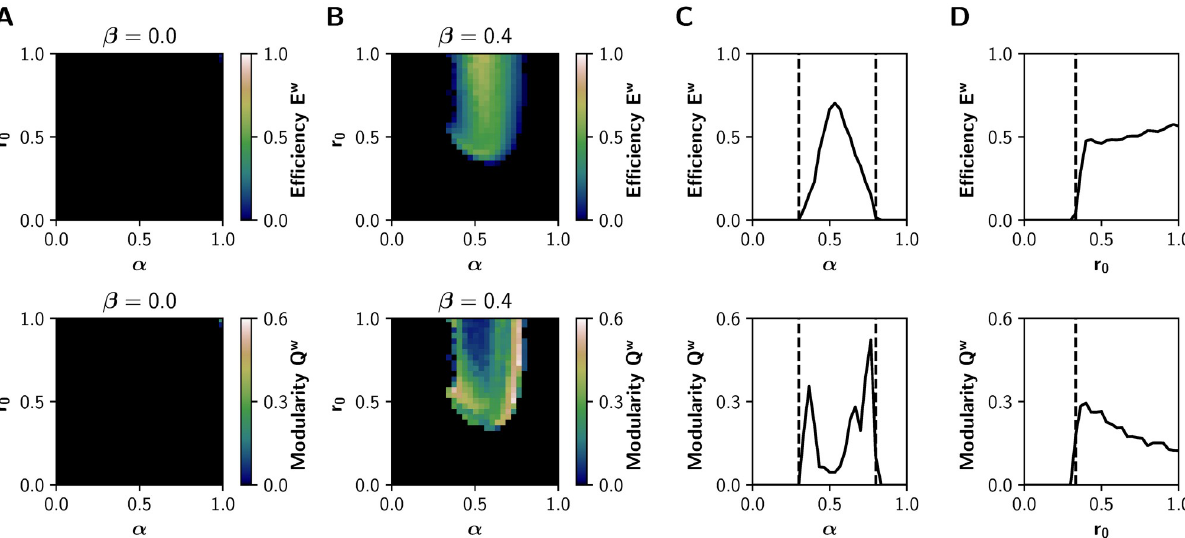
Fig 4. Network features in the ( α , r 0 ) parameter space. A-B) Global efficiency E w (integration) and modularity Q w (segregation) of the graphs derived from the sFCs of the BOLD-like signals, for A) β = 0 (no action of the inhibitory gain) and B) β = 0.4. C) Transitions through the critical boundary in the α axis, with a fixed r 0 = 1 mV − 1 and β = 0.4. Critical transition points represented by black dashed lines at α = 0.3 and α = 0.8. D) Transitions in the r 0 axis, for a fixed α = 0.6 and β = 0.4, with a critical transition at r 0 = 0.33 mV − 1 .